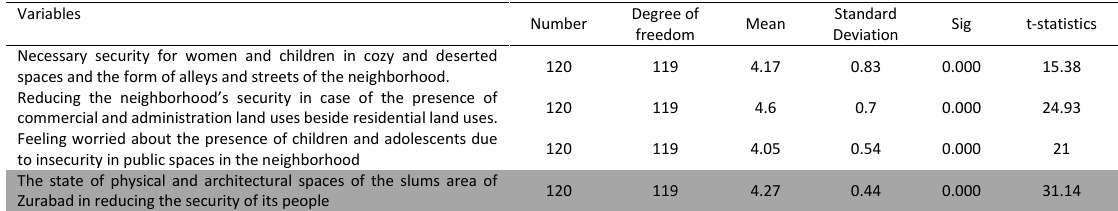
Table 5: Test results for the current state of architectural and physical spaces of the slums area of Zurabad of Karaj in reducing the security of its people Variables